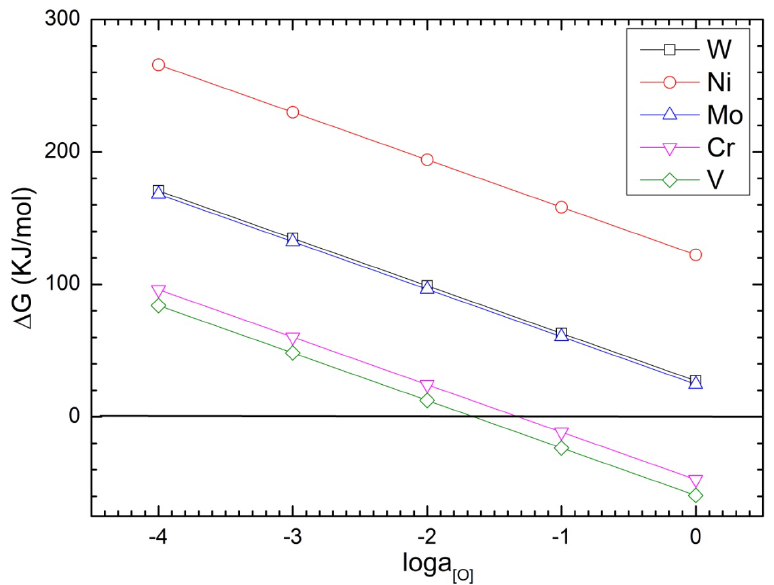
Figure 2. Effect of oxygen activity on the Gibbs free energy of oxidation for Ni, W, Mo, V and Cr at 1873 K. 1873